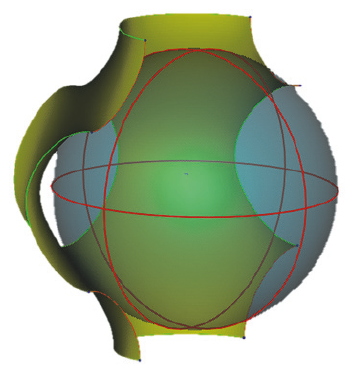
Figure 5: Pore size